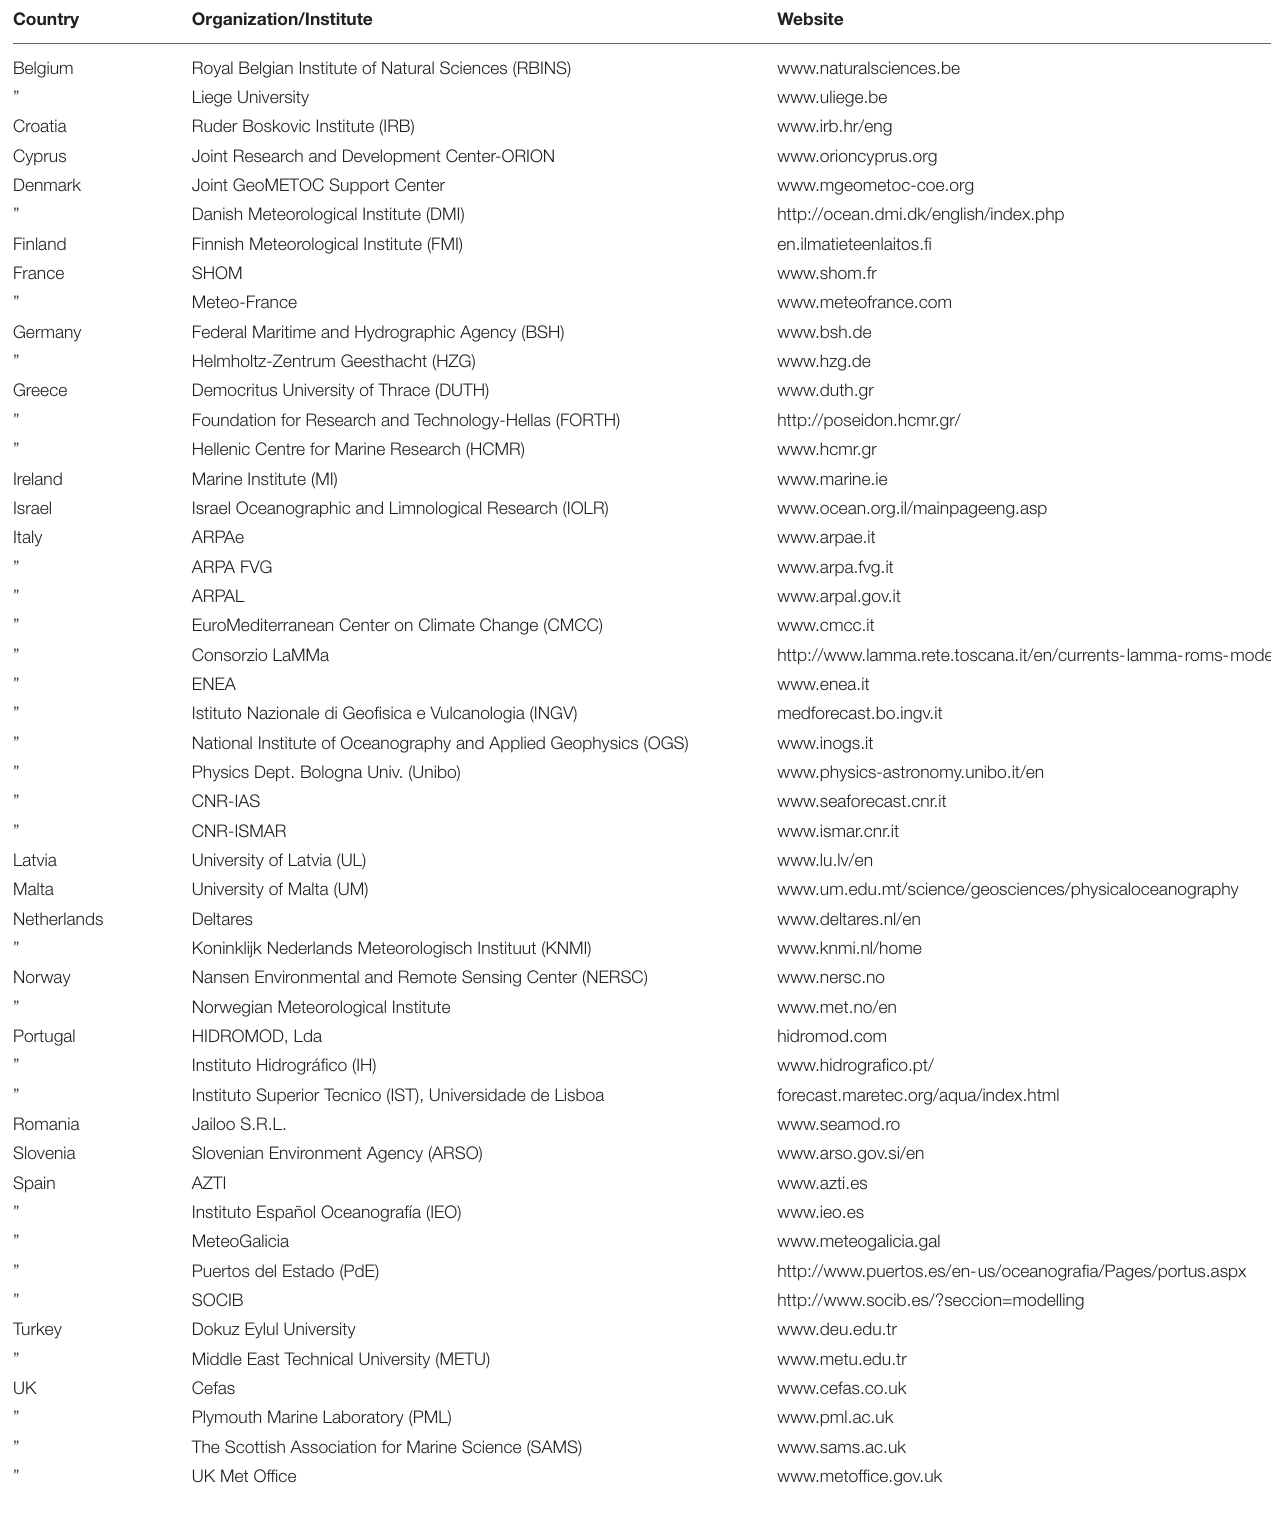
TABLE 1 | Reference website institutes and organizations having contributed to the survey.